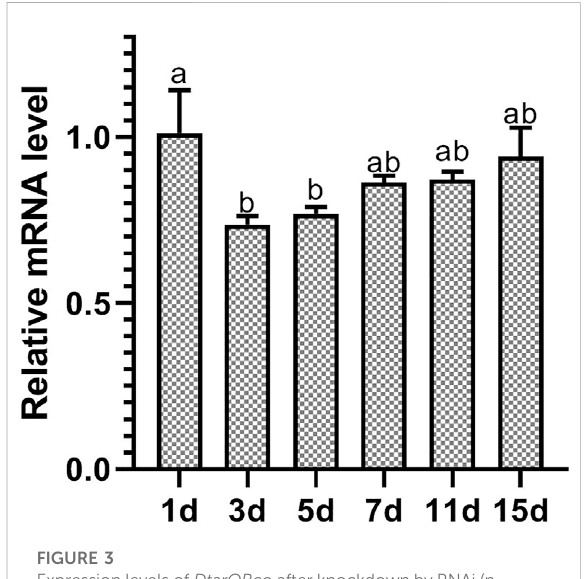
FIGURE 3 Expression levels of DtarORco after knockdown by RNAi (n = 3, p < 0.05).